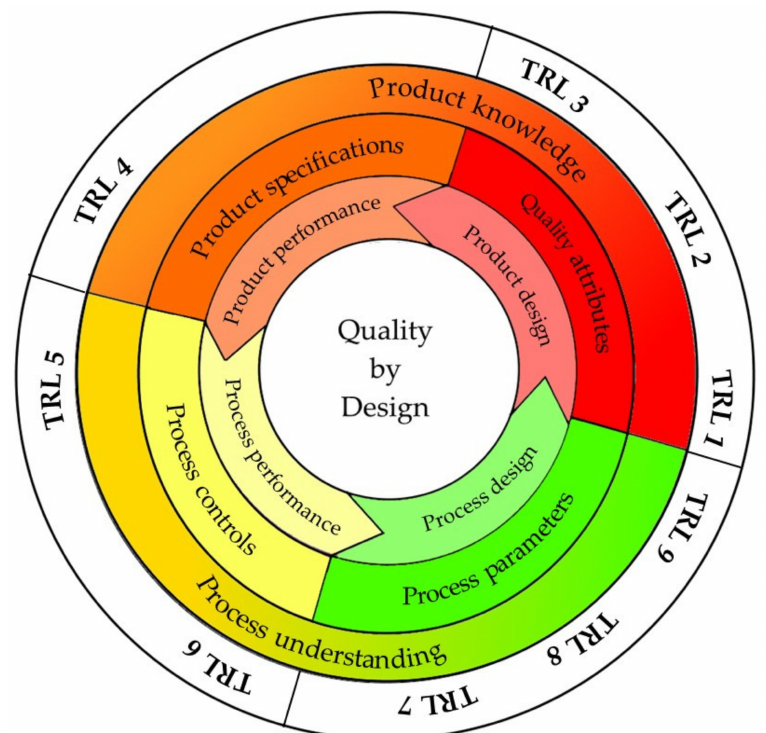
Figure 3. Concept of Quality by Design (QbD) for the development of medical devices (MDs) and the di ff erent steps with the corresponding technology readiness level (TRL). Modified from [74]. CC BY